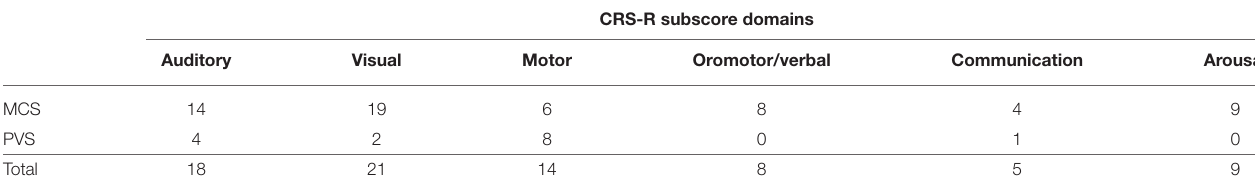
TABLE 4 | Number of patients with response stratified by disorder of consciousness and domain of CRS-R subscore improvement.